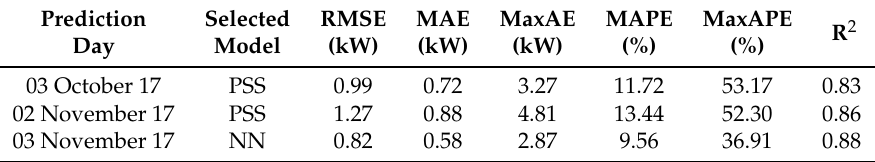
Figure 12. Pilot system: Municipal office (Monopoli), Day: 3 November 2017. Daily forecasts vs. observed power consumption. Table 3. Pilot system: Municipal office (Monopoli). Computational Results (UpdFreq = 24